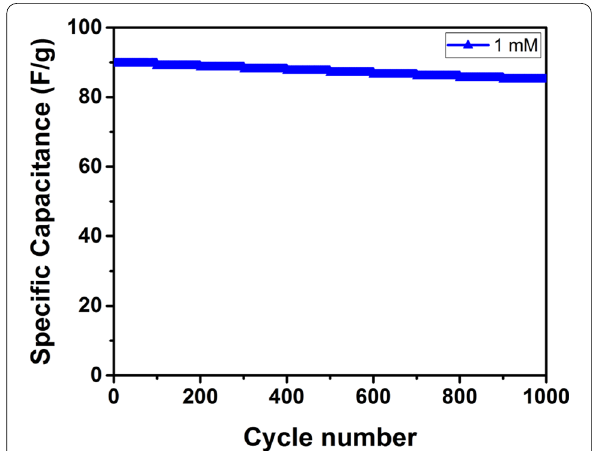
Fig. 7 Cyclic stability of 1. 0 mM MB electrode from charge/discharge studies at current density of 0.3